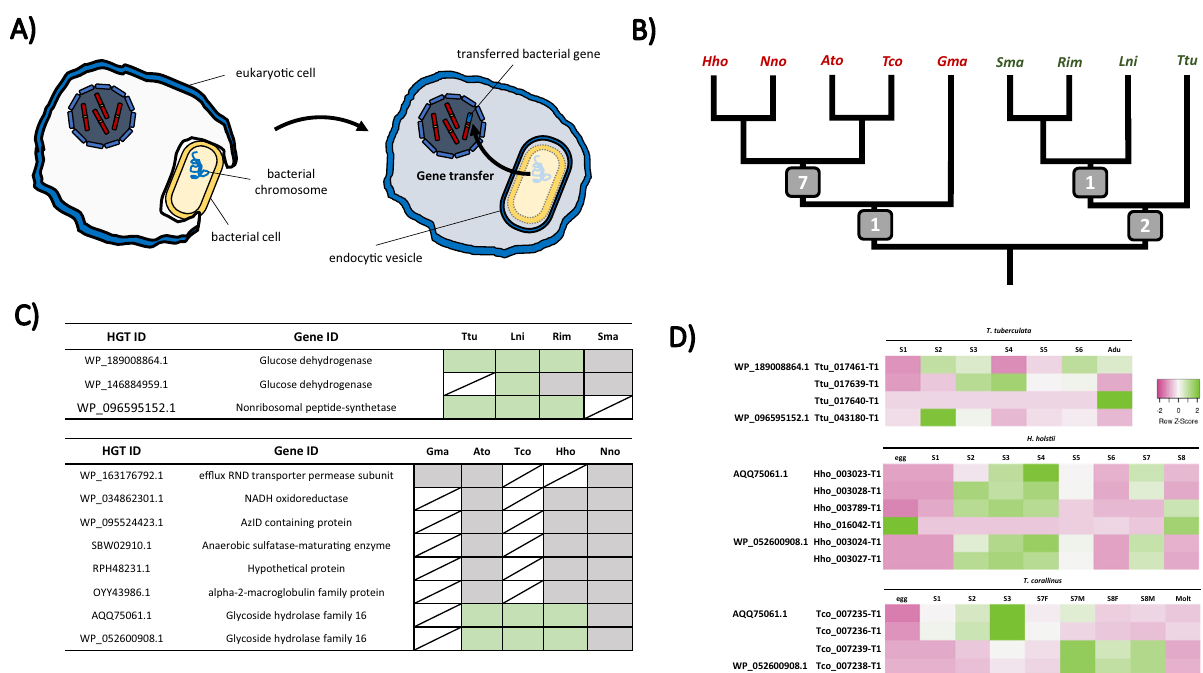
Fig. 5 Horizontal gene transfer (HGT) in myriapods. A Schematic diagram showing a typical HGT events from prokaryotic cells to eukaryotic cell. B Summary of HGT events identi fi ed in different myriapod lineage in this study. The numbers at the nodes indicate the HGT event identi fi ed in each lineage common ancestor. C HGT candidates identi fi ed and their presence (labelled in green) in each myriapod lineage. D Gene expression of HGT candidates in T. tuberculata , H. holstii and T. corallinus transcriptomes (this study and Qu et al., 2020) The colours indicate the degree of row Z score (green indicates upregulation while pink indicates downregulation).